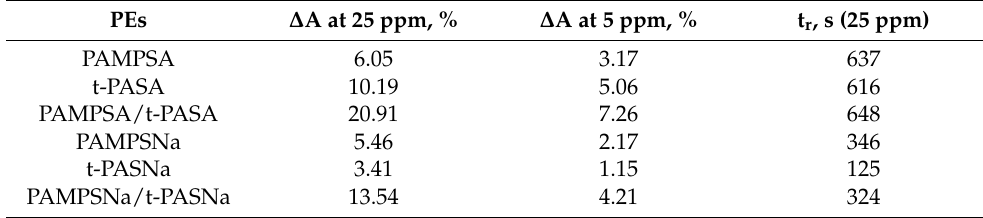
Table 3. Values of response amplitude ( ∆ A) and response time (t r ) of PEDOT films.